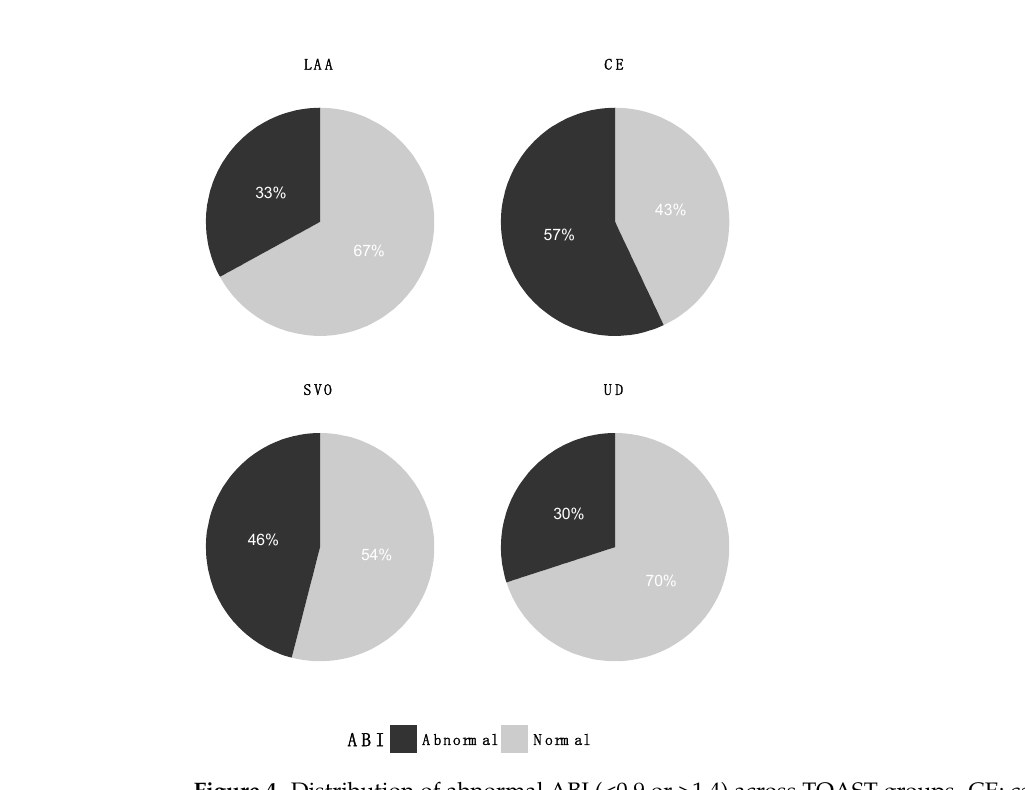
Figure 4. Distribution of abnormal ABI (<0.9 or >1.4) across TOAST groups. CE: cardioembolism; LAA: large artery atherosclerosis; SVO: small vessel occlusion; UD: undetermined etiology.